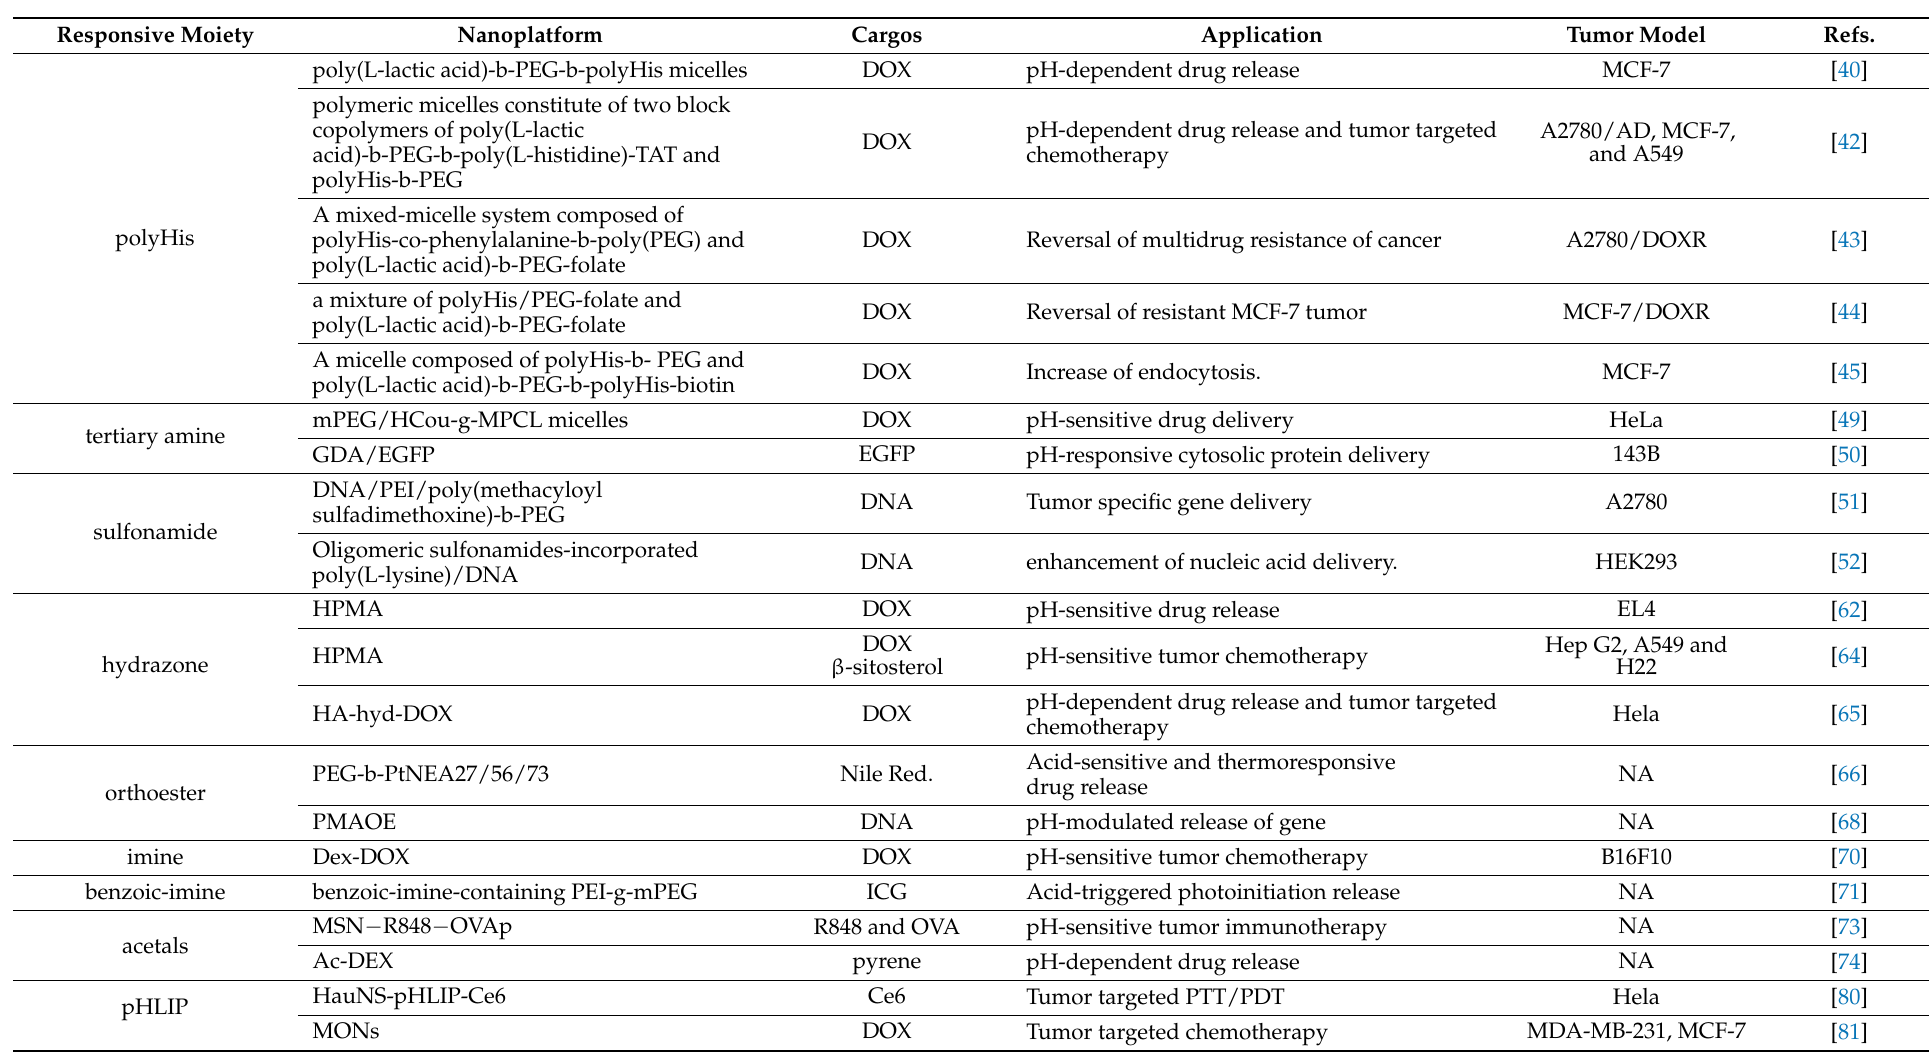
Table 1. pH-responsive srNPs in cancer